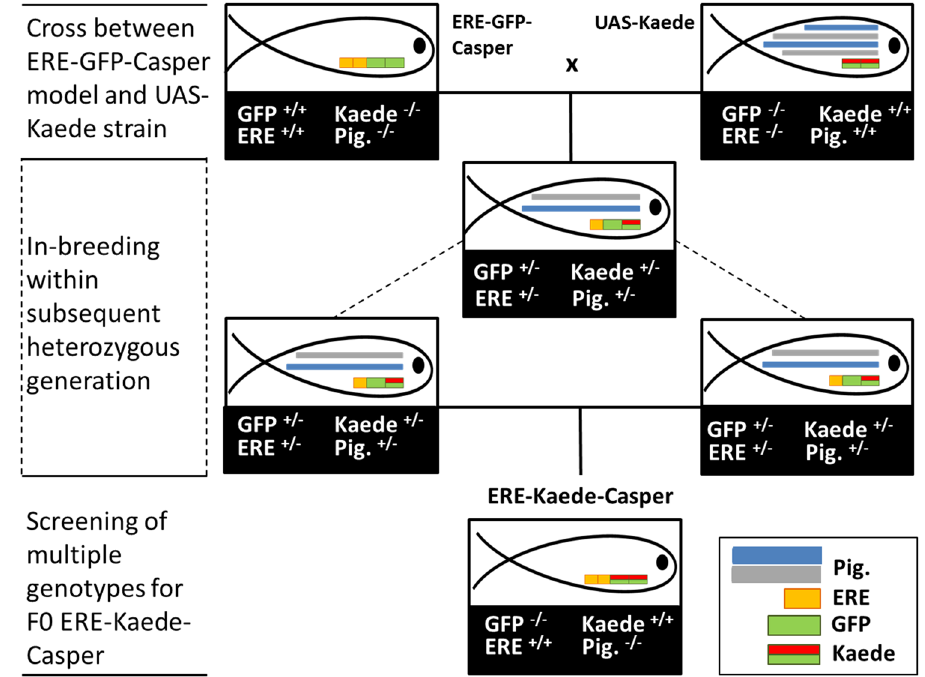
Figure 1. Generation of ERE-Kaede-Casper (F0) line. ERE denotes the ERE-Gal4ff transgene sequence, GFP denotes the UAS-GFP transgene sequence and Kaede denotes the UAS-Kaede transgene sequence. Expression of pigmentation (Pig.) genes roy (dark) and nacre (silver) are also shown. The ERE-GFP-Casper model, homozygous for both transgene sequences, and a homozygous UAS-Kaede strain were initially crossed to produce a heterozygous generation. In-breeding within this generation produced progeny with different genotypes based on four genes of interest. At sexual maturity, F0 ERE-Kaede-Casper adults were identified by screening for photoconvertible progeny with fully silenced pigmentation and TG(ERE:Gal4ff)(UAS:Kaede)